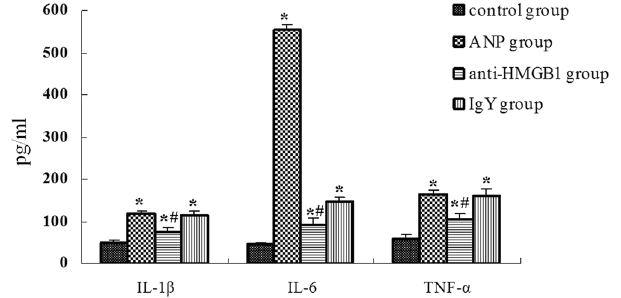
Figure 3. Serum IL-1 β , IL-6, TNF- α levels detected by ELISA. Data expressed as the means ± SD. * P < 0.05 versus control group. # P < 0.05 versus ANP